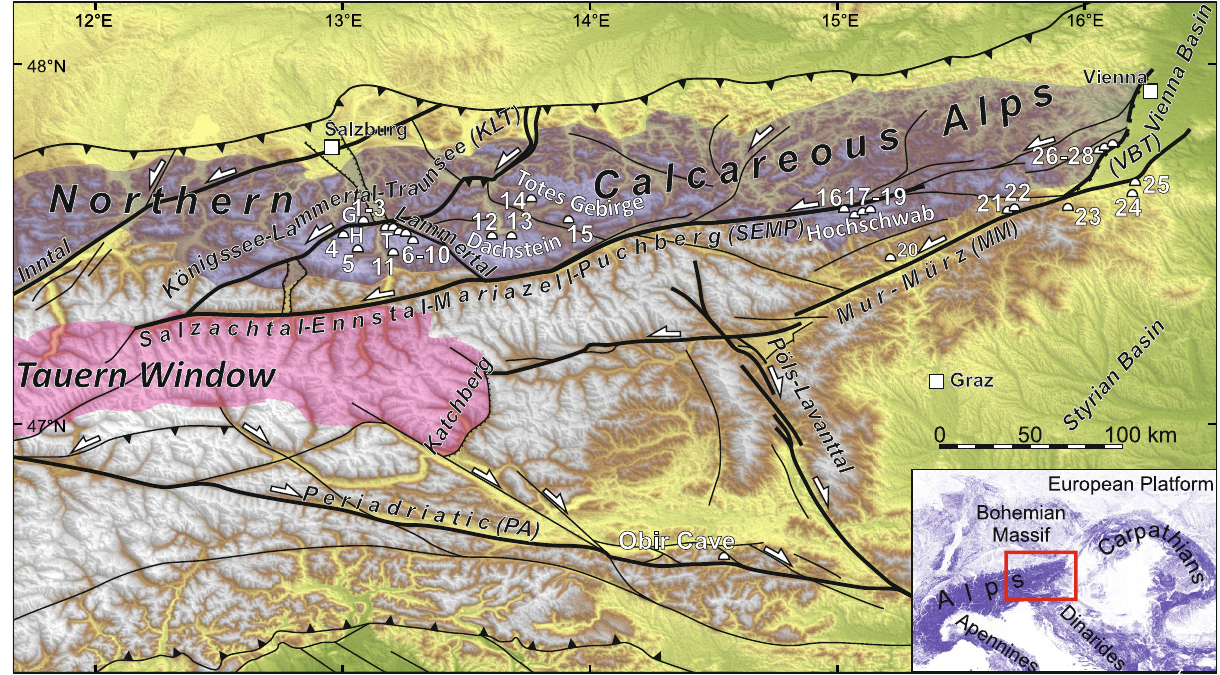
Figure 1. Major fault systems accomodating lateral extrusion of the Eastern Alps [after 1, 2, 6] imposed on Shuttle Radar Topography Mission (SRTM) 1 arc-second shaded relief with digital elevation model (https:// www2. jpl. nasa. gov/ srtm/; CC BY 4.0 ). Studied caves: 1. Gruberhorn, 2. Gamssteig, 3. Dependance, 4. Interessante, 5. Tantal, 6. Bierloch, 7. Berger, 8. Schneeloch, 9. Felsbrücken, 10. Jack’Daniels,